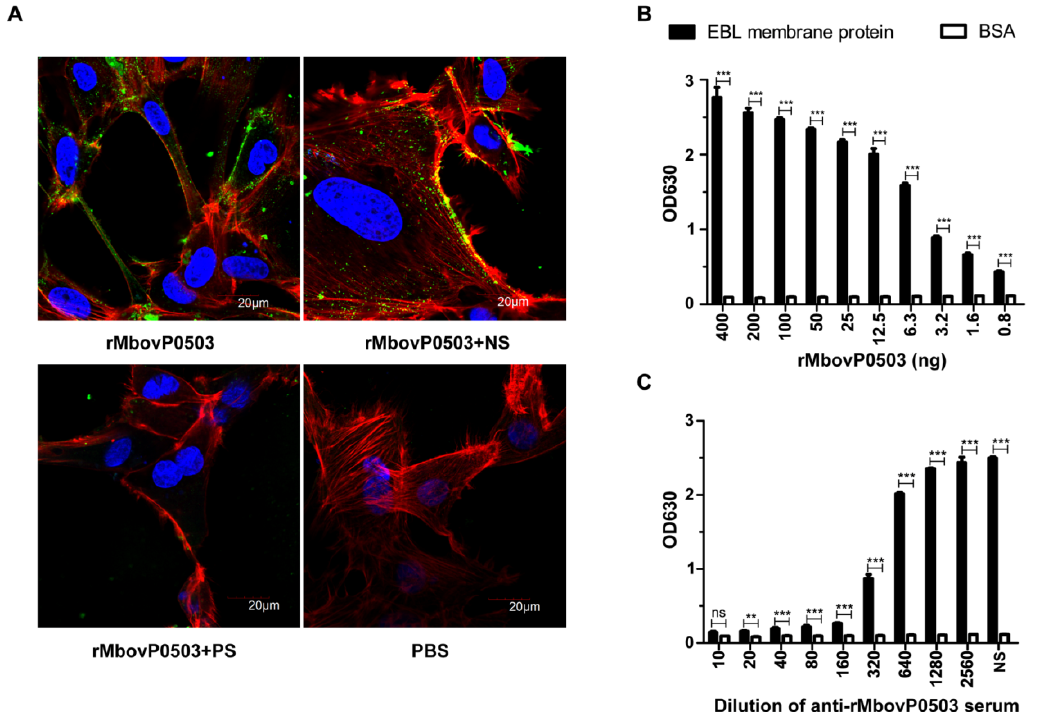
Figure 4. Adhesion of rMbovP0503 to EBL cells. ( A ) Visualization of rMbovP0503 bound to EBL cells by laser scanning confocal microscopy. EBL cells were incubated with 10 µ g rMbovP0503 (rMbovP0503). PBS was used as a negative control. For the adhesion inhibition assay, rMbovP0503 was preincubated with rMbovP0503 antiserum (rMbovP0503 + PS) or negative serum (rMbovP0503 + NS). Proteins were probed with anti-rMbovP0503 antibodies and Alexia 488-conjugated anti-IgG antibodies (Green). Actin filaments and nuclei were labeled with Rhodamine phalloidin (Red) and DAPI (Blue), respectively. ( B ) Dose-dependent binding of rMbovP0503 to EBL membrane extracts. ELISA plates coated with 400 ng EBL membrane extracts or 400 ng BSA were incubated with serial dilutions of rMbovP0503. ( C ) Inhibition of rMbovP0503 binding to EBL membrane extracts by rMbovP0503 antiserum. rMbovP0503 (400 ng) was preincubated with serial dilutions of rMbovP0503 antiserum before incubation with EBL membrane extracts or BSA. P values are indicated by asterisks (*** p < 0.001; ** p < 0.01; ns = p > 0.05).